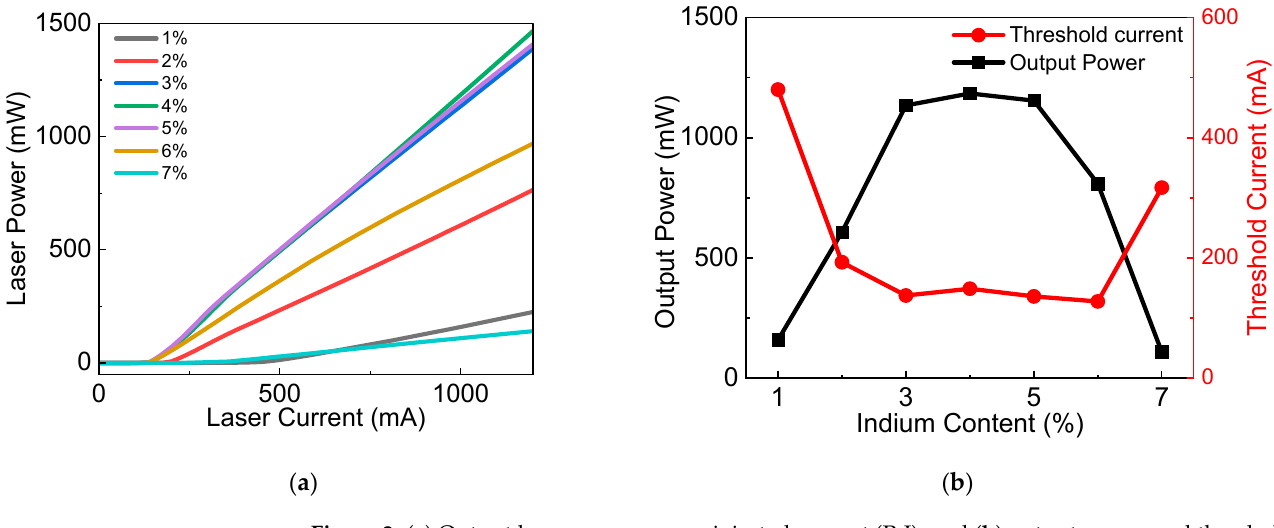
Figure 2. ( a ) Output laser power versus injected current (P-I), and ( b ) output power and threshold current versus indium content in quantum barriers. (All the output power data are collected under the same injection current of 1000 mA).